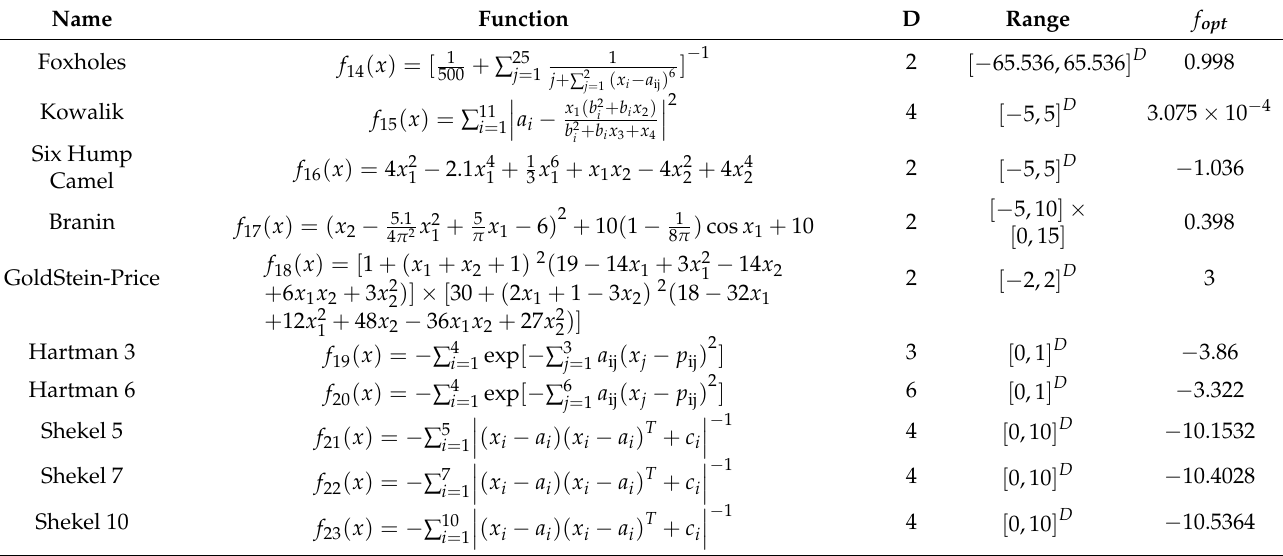
Table A3. Low-dimension Multimodal test